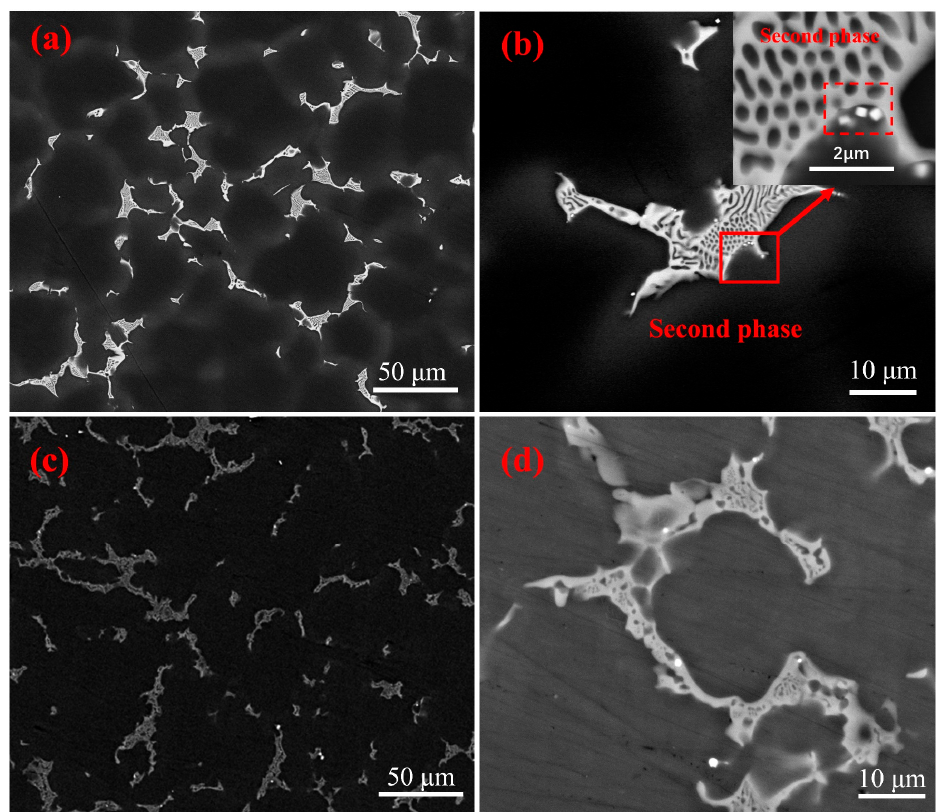
Figure 2. The surface morphology of ( a , b ) WE43 and ( c , d ) AZ80.